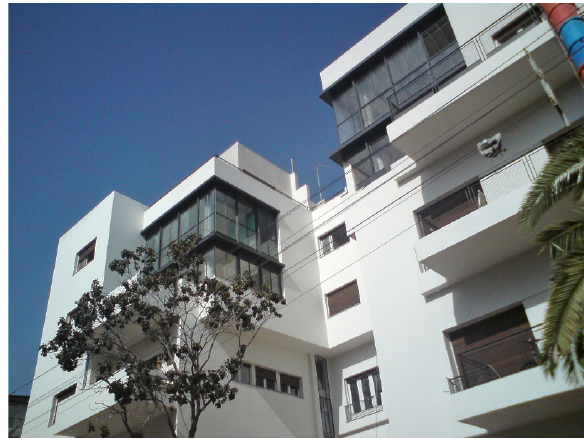
Figure 2. Example of an International Style building in the